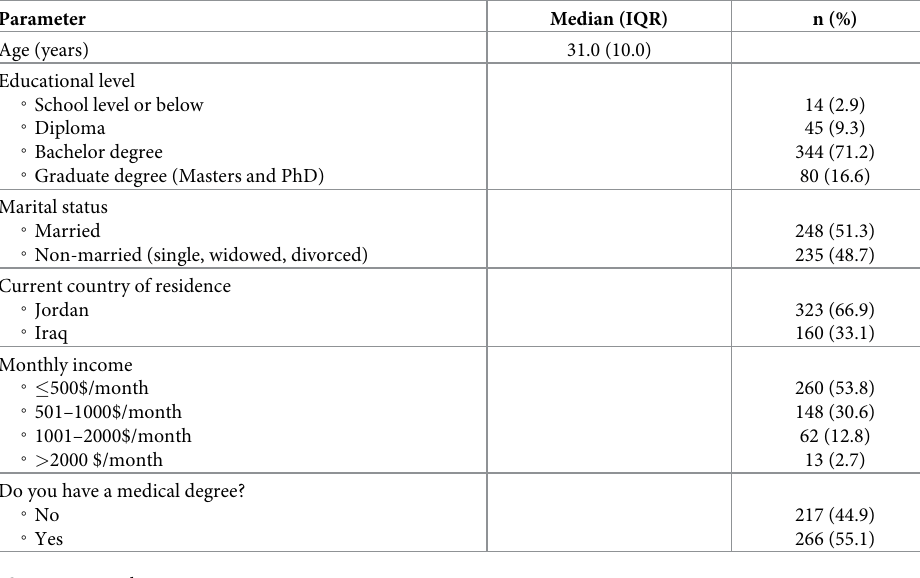
Table 1. Socio-demographic characteristics of the study sample (n =